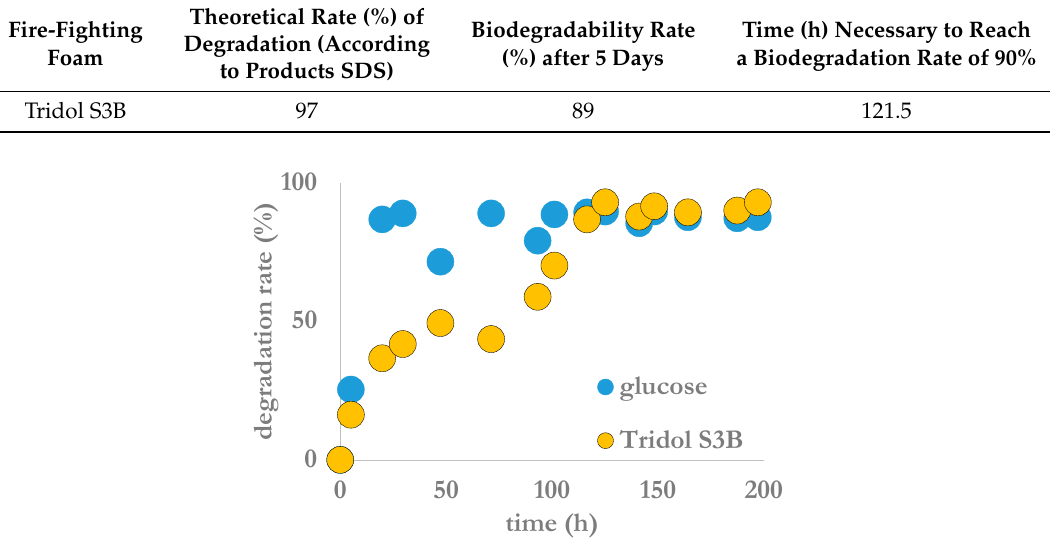
Figure 5. Degradation rate of the fire-fighting foam Tridol S3B as a function of time according to the OECD 301 F protocol. Table 3. Results of aerobic biodegradation tests on the three fire-fighting foams.